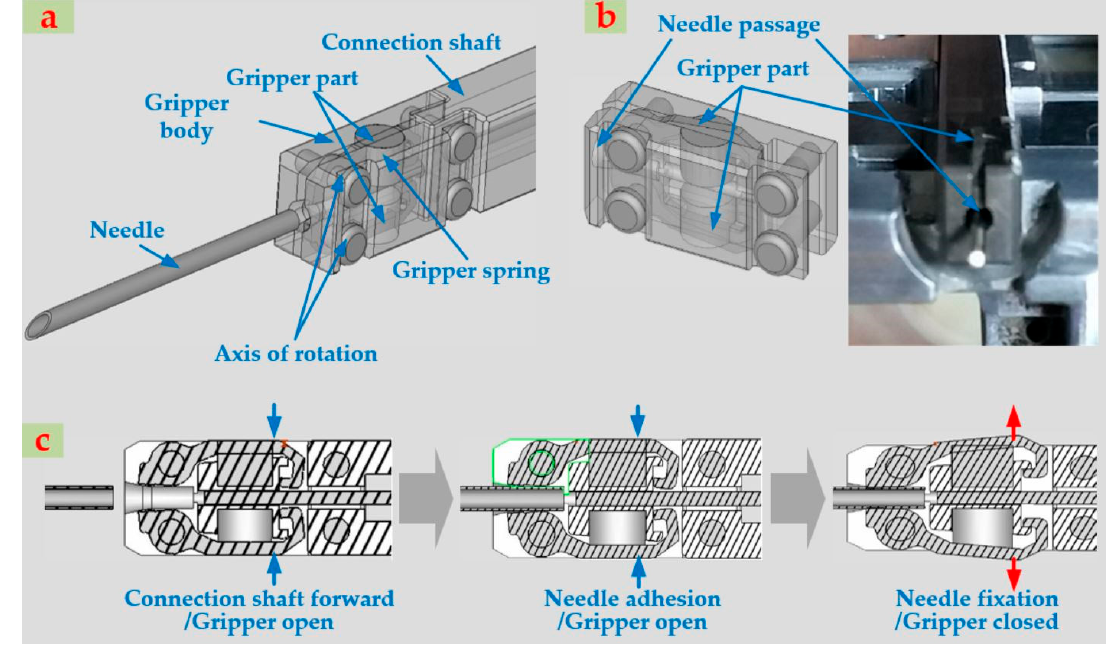
Figure 8. Grip and release of needle by the gripper. ( a ) Structure of the gripper, ( b ) needle grip of the gripper, and ( c ) gripper part.